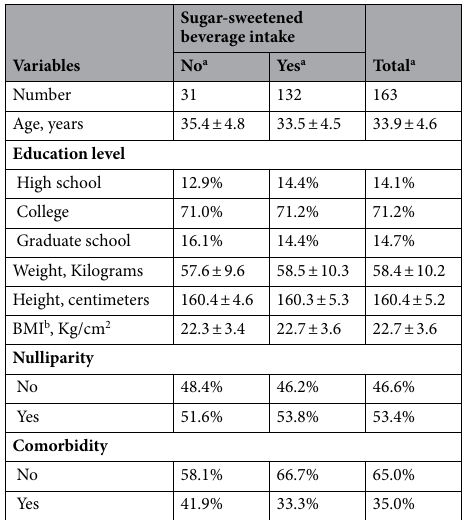
Table 2. Demographic characteristics of the studied cohort. a Data are given in number, percentage or mean ± standard deviation. b BMI at study entry.